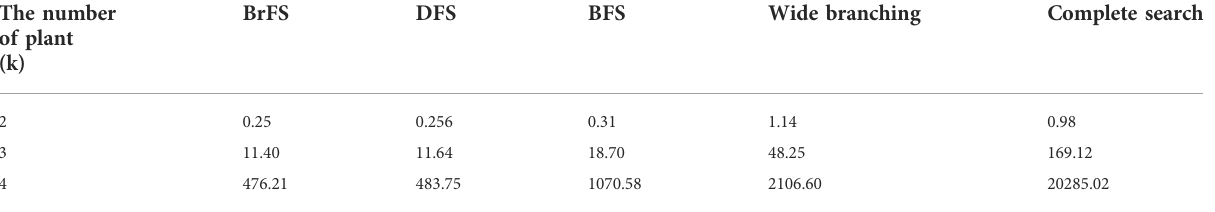
FIGURE 9 Wide branching strategy.